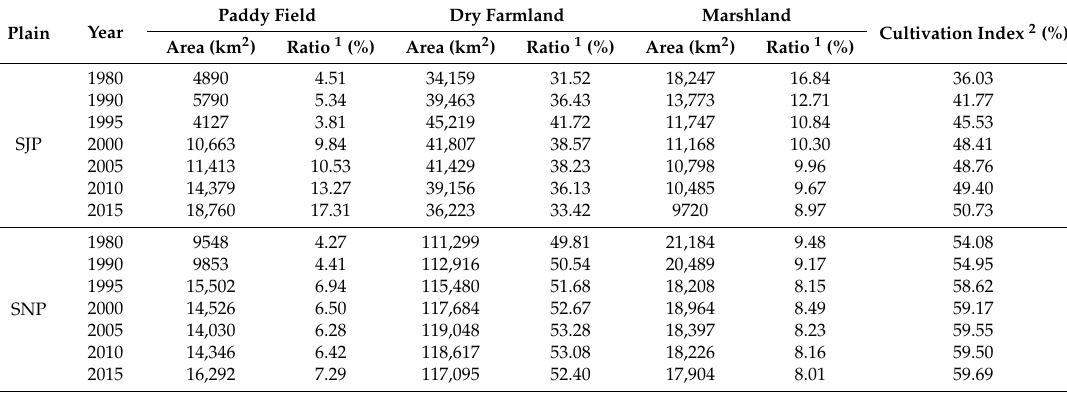
Table 4. Major LULC statistics in the SJP and SNP during the period 1980–2015. Plain